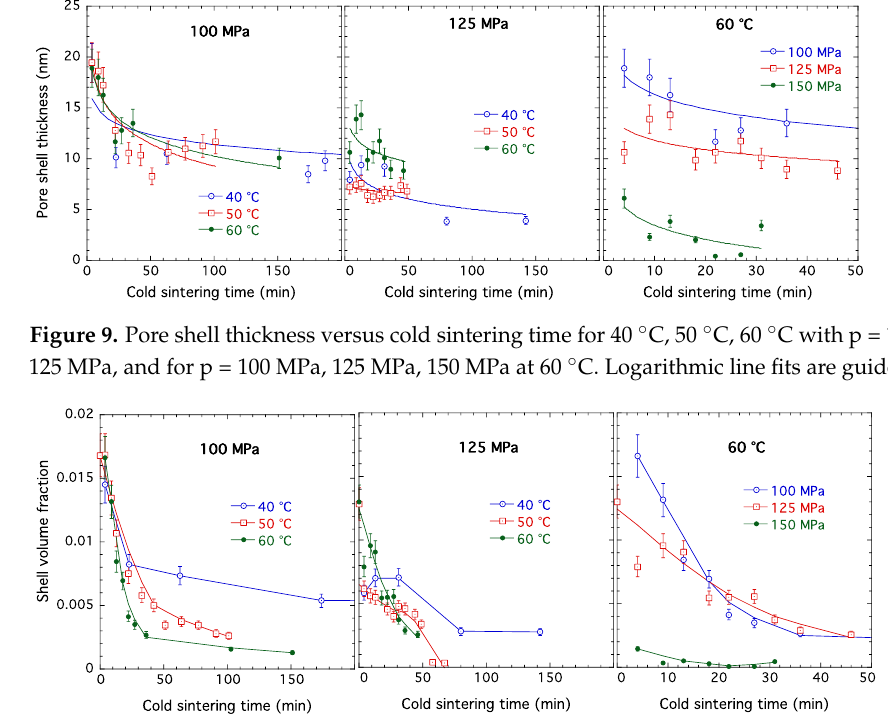
Figure 10. Shell volume fraction versus cold sintering time for 40 °C, 50 °C, 60 °C with p = 100 MPa and 125 MPa, and for p = 100 MPa, 125 MPa, 150 MPa at 60 °C. Lines are guide to the eye.